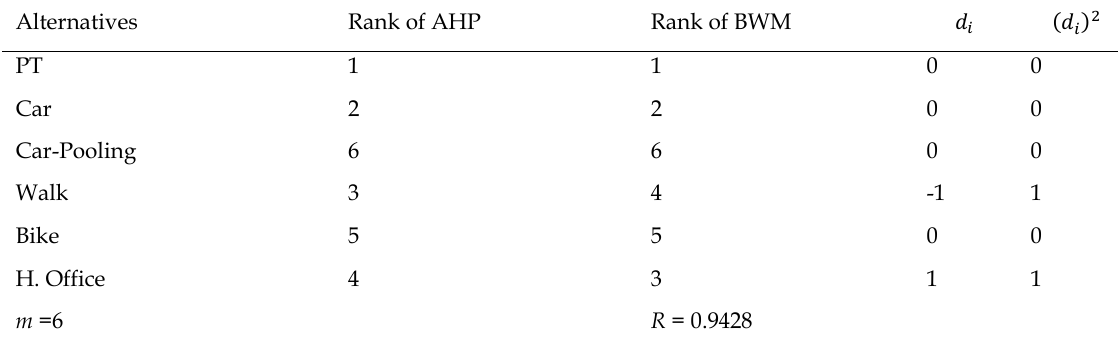
Spearman’s rank correlation coefficient for Group